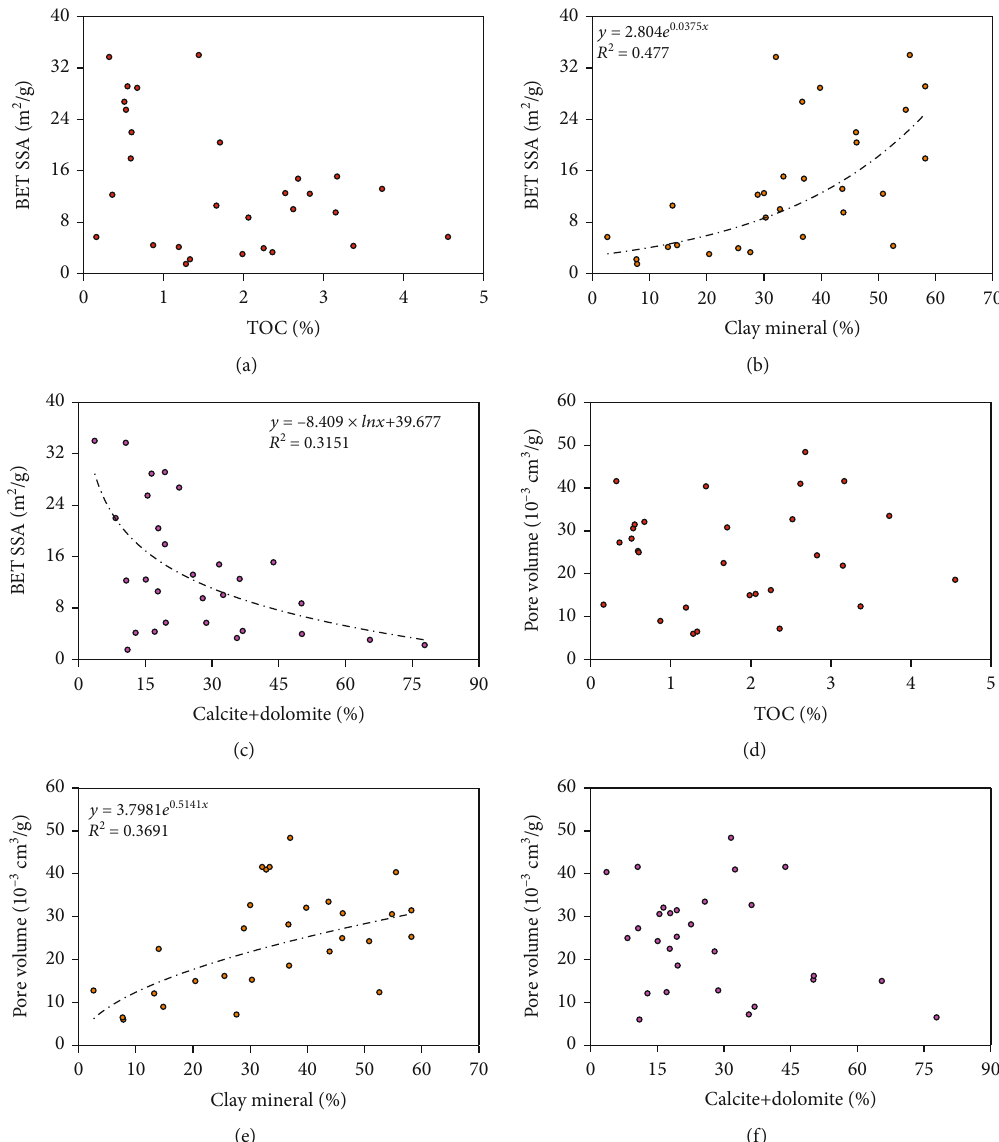
Figure 8: Relationships between the speci fi c surface area and the TOC (a), clay minerals (b), and calcite +dolomite (c) and relationships between the pore volume and the TOC (d), clay minerals (e), and calcite +dolomite